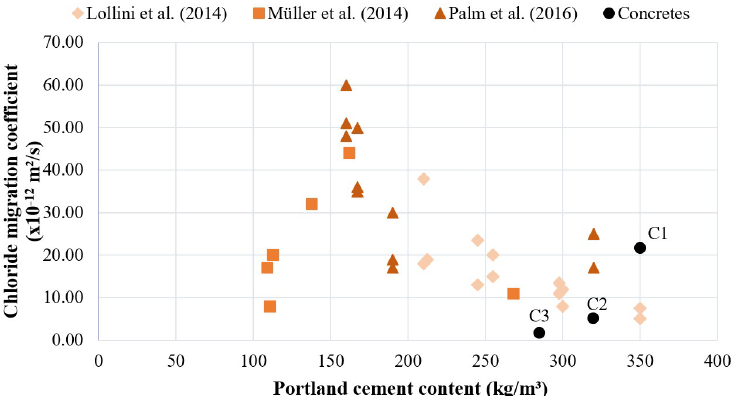
Figure 6. Chloride migration coefficient versus Portland cement content